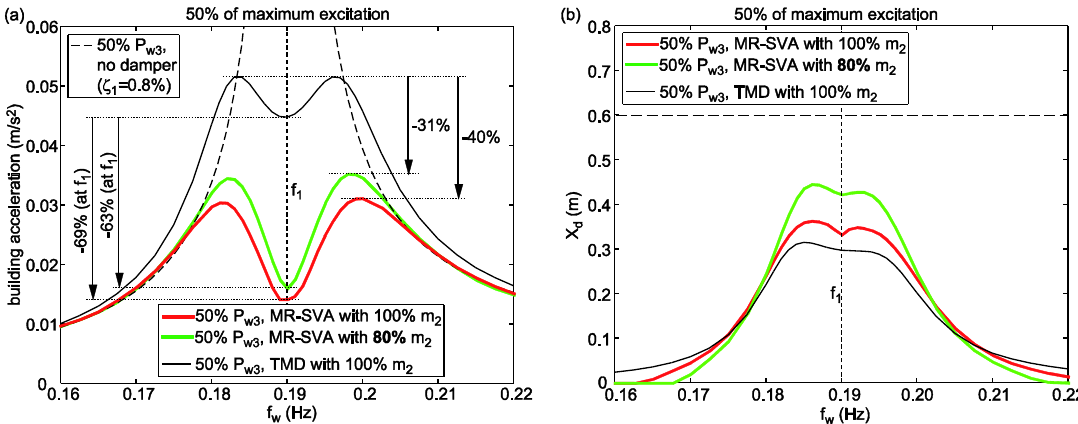
Figure 23. Simulated ( a ) vibration reduction and ( b ) relative motion amplitude for 50% of maximum excitation of primary structure with MR-SVA with nominal and reduced (80%) pendulum masses.